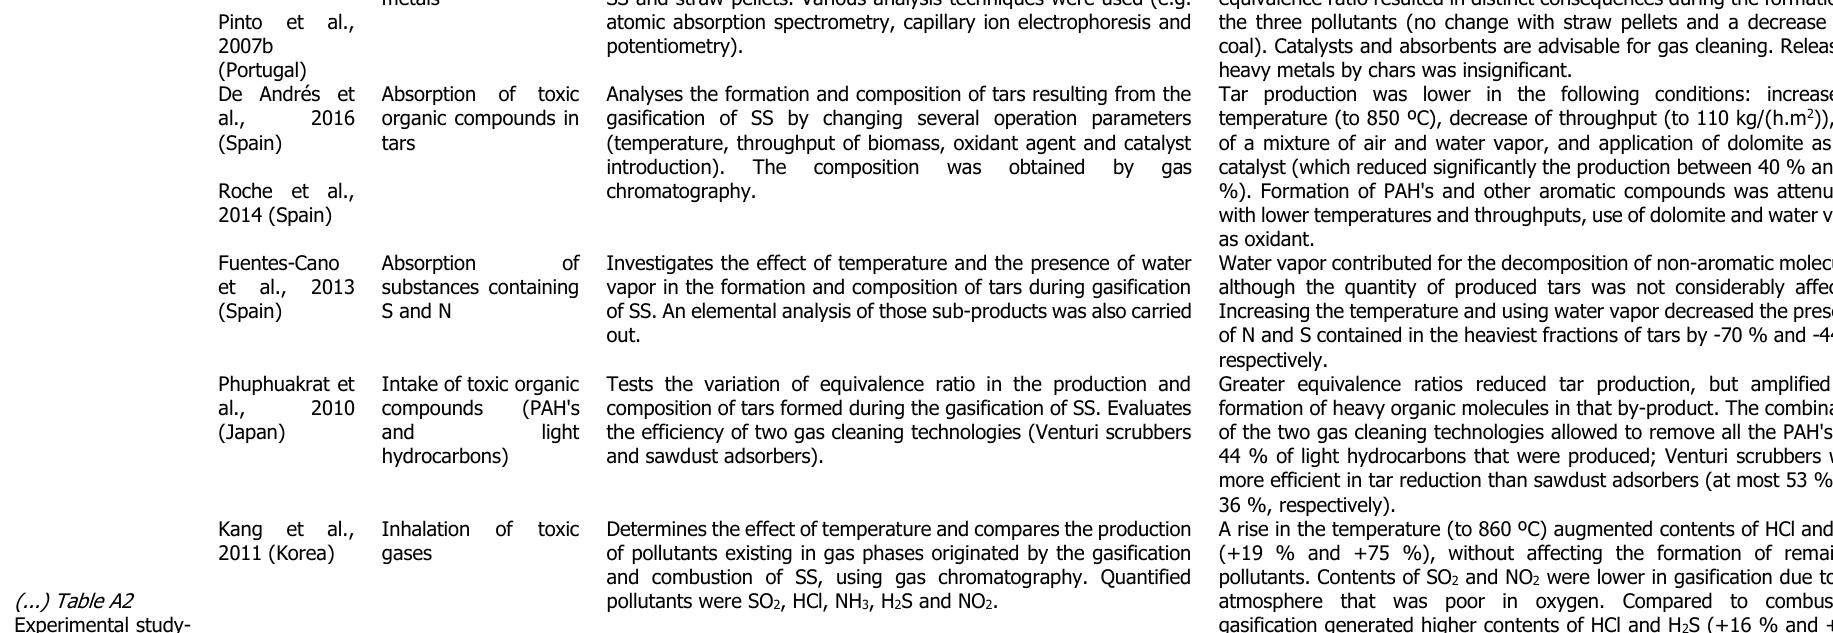
(...) Table A2 Experimental